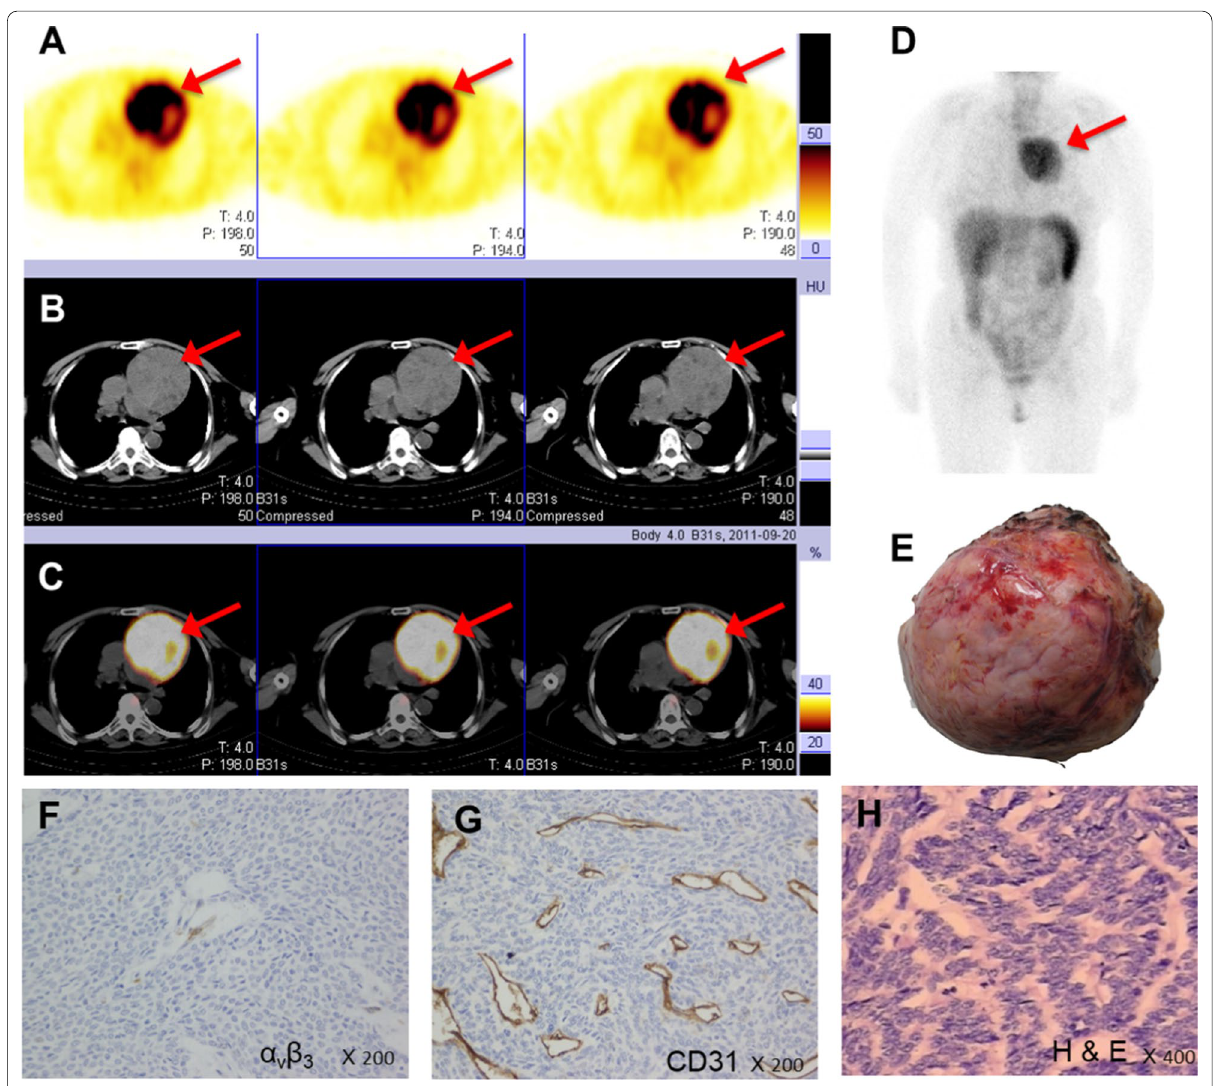
Fig. 5 Female patient with an anterior mediastinum lesion, the final diagnosis was thymus adenoma. a – d [ 99m Tc]Tc-Galacto-RGD2 imaging showed high focal uptake. e The surface of the tumour showed many new vessels. f , g IHC showed a high density of neovascularization with high